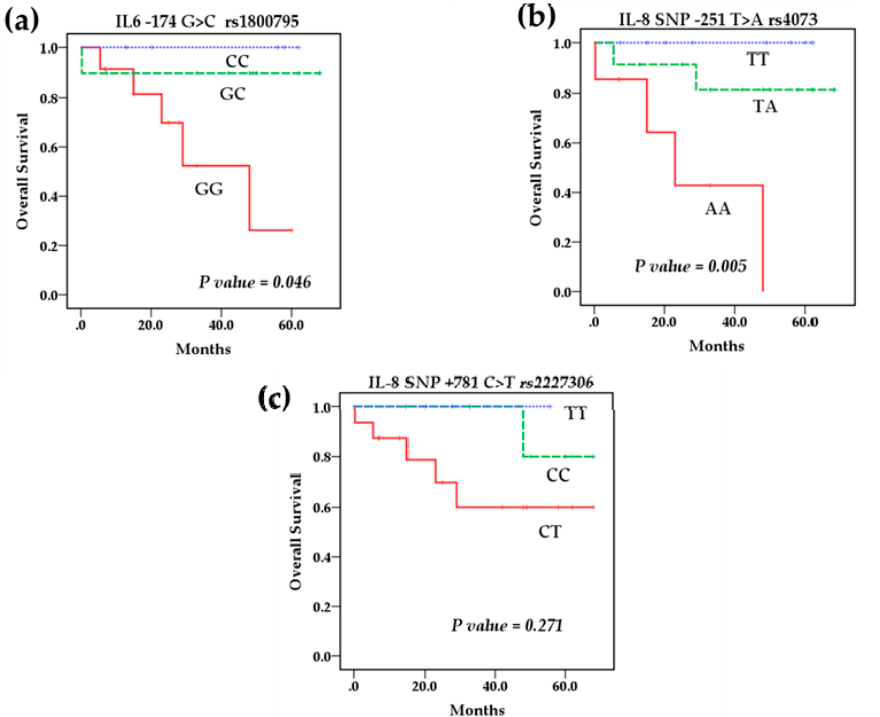
Figure 2. Kaplan–Meier curves of overall survival by genotype for ( a ) SNP rs1800795 IL-6, ( b ) SNP rs4073 IL-8, and ( c ) SNP rs2227306 IL-8.